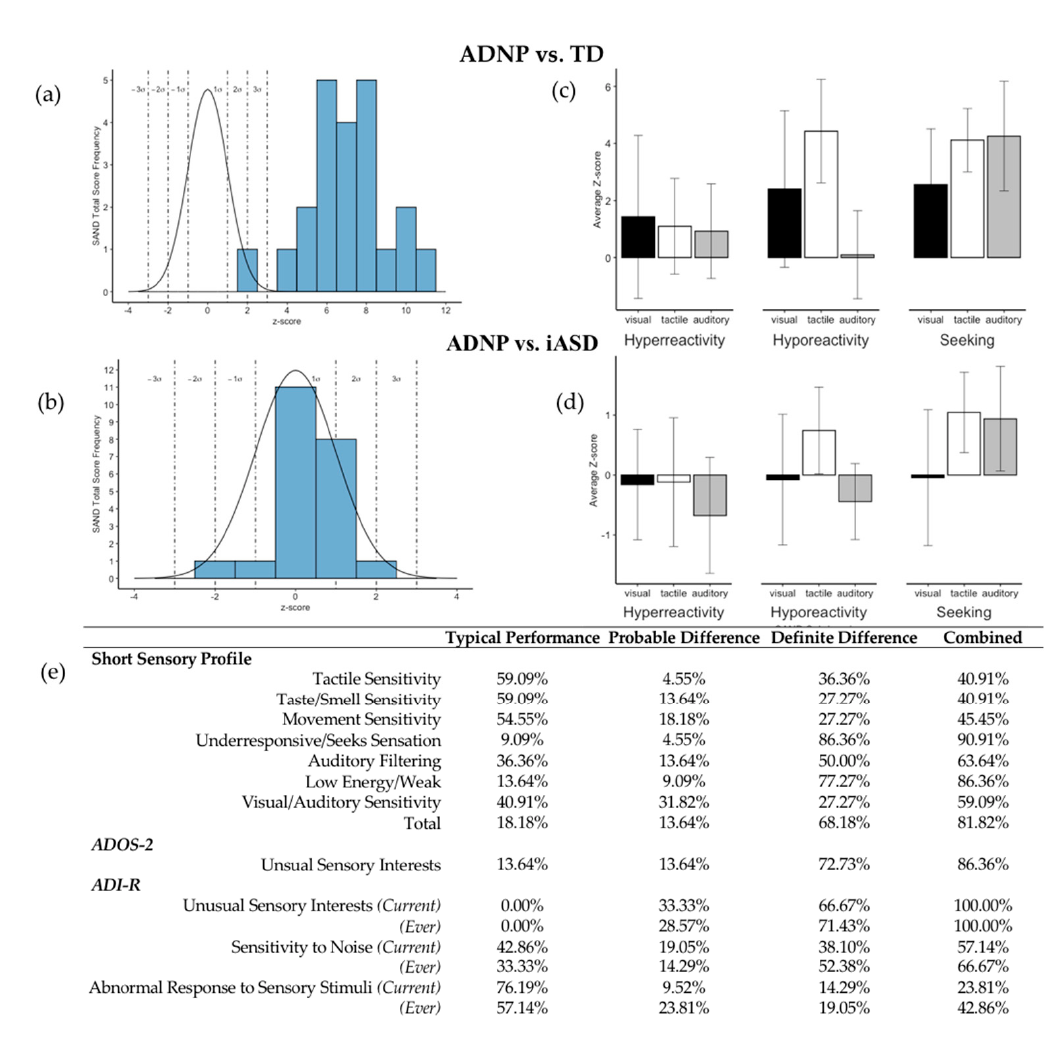
Figure 2 . ( a ) Score distributions for individuals with ADNP syndrome relative to TD controls and ( b ) iASD from a normative sample. Dashed limit lines represent one, two, and three standard deviations above and below the mean. ( c ) Sensory hyperreactivity, hyporeactivity and seeking within visual, tactile, and auditory modalities based on TD z-scores. ( d ) Sensory hyperreactivity, hyporeactivity and seeking within visual, tactile, and auditory modalities based on iASD z-scores. Z-scores have a mean of 0 where +1 indicates 1 SD above the mean. ( e ) Frequency of sensory behaviors on the SSP, ADOS-2, and ADI-R. The ‘combined difference’ column reflects the sum of the ‘probable difference’ and ‘definite difference’